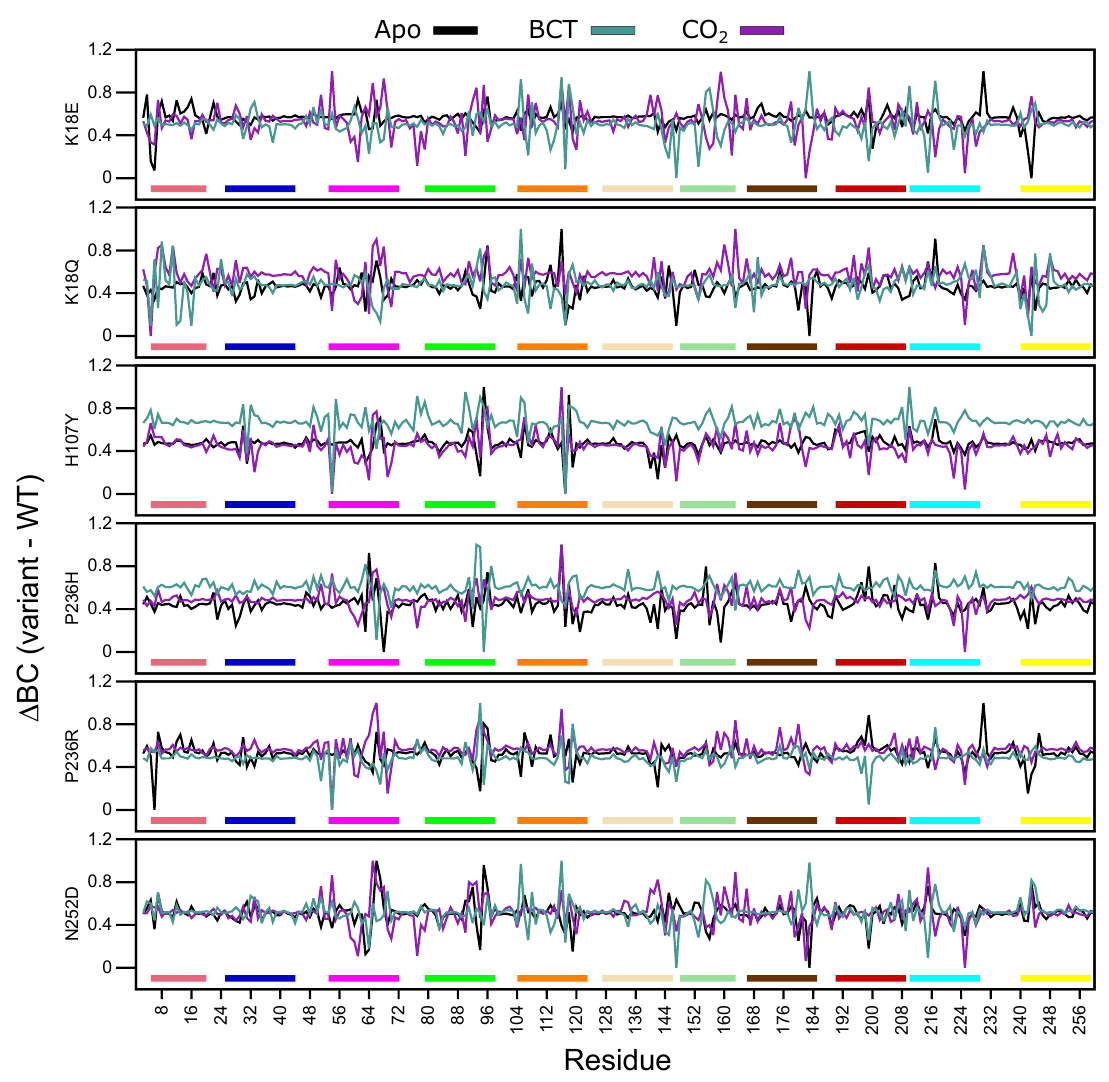
Figure 9. Change in betweenness centrality ( BC ) between the WT and variant protein (variant minus WT) over the MD simulation. Respective motifs are indicated as bars at the bottom of each plot. Motif colors correspond to those in Figure